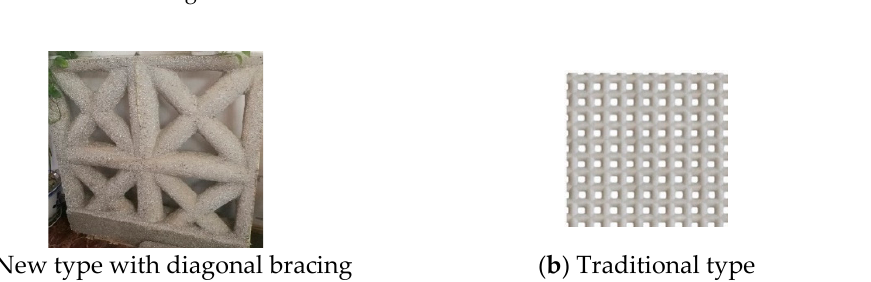
Figure 2. The skeleton of the latticed concrete wall.